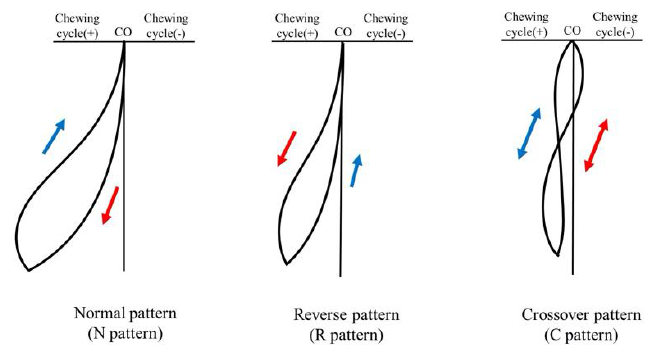
Figure 7. Schematic drawing of a chewing cycle from the frontal view. A chewing exercise using chewing gum (NOTIME, LOTTE Co. Ltd., Tokyo,